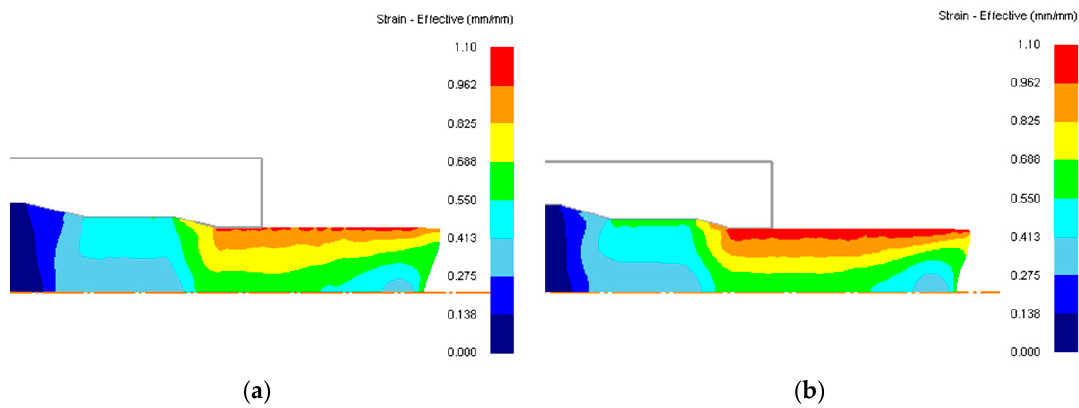
Figure 17. Comparison of strain distributions ( R T = 45.55%, α ≅ 12.6° [23]); ( a ) Steel UNS G10550; ( b ) Steel DP800.